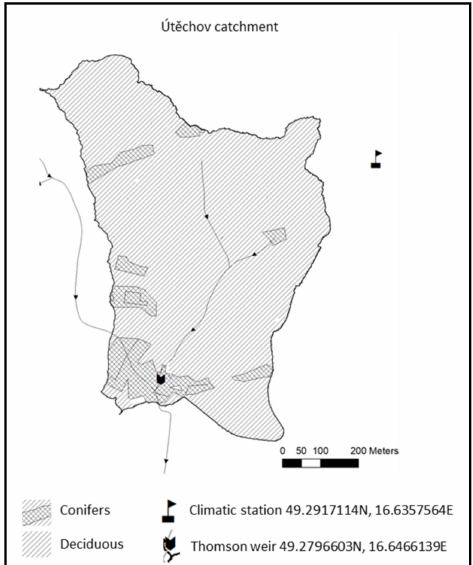
Figure 1. Localization of the study